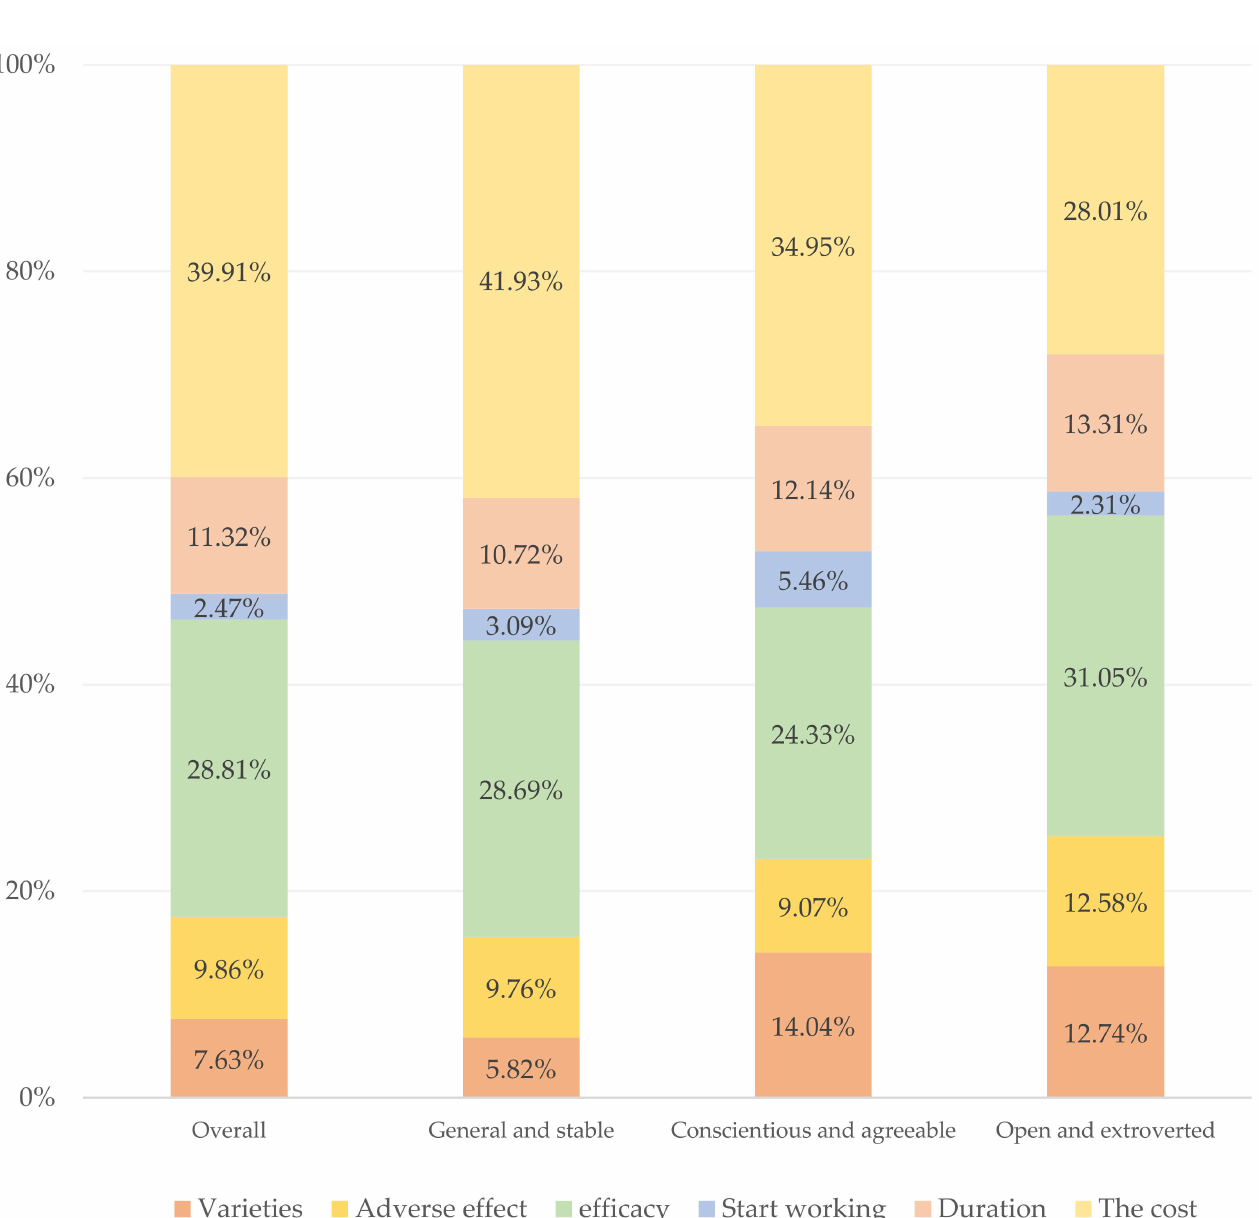
Figure 2. Percentage importance of attributes in latent profile